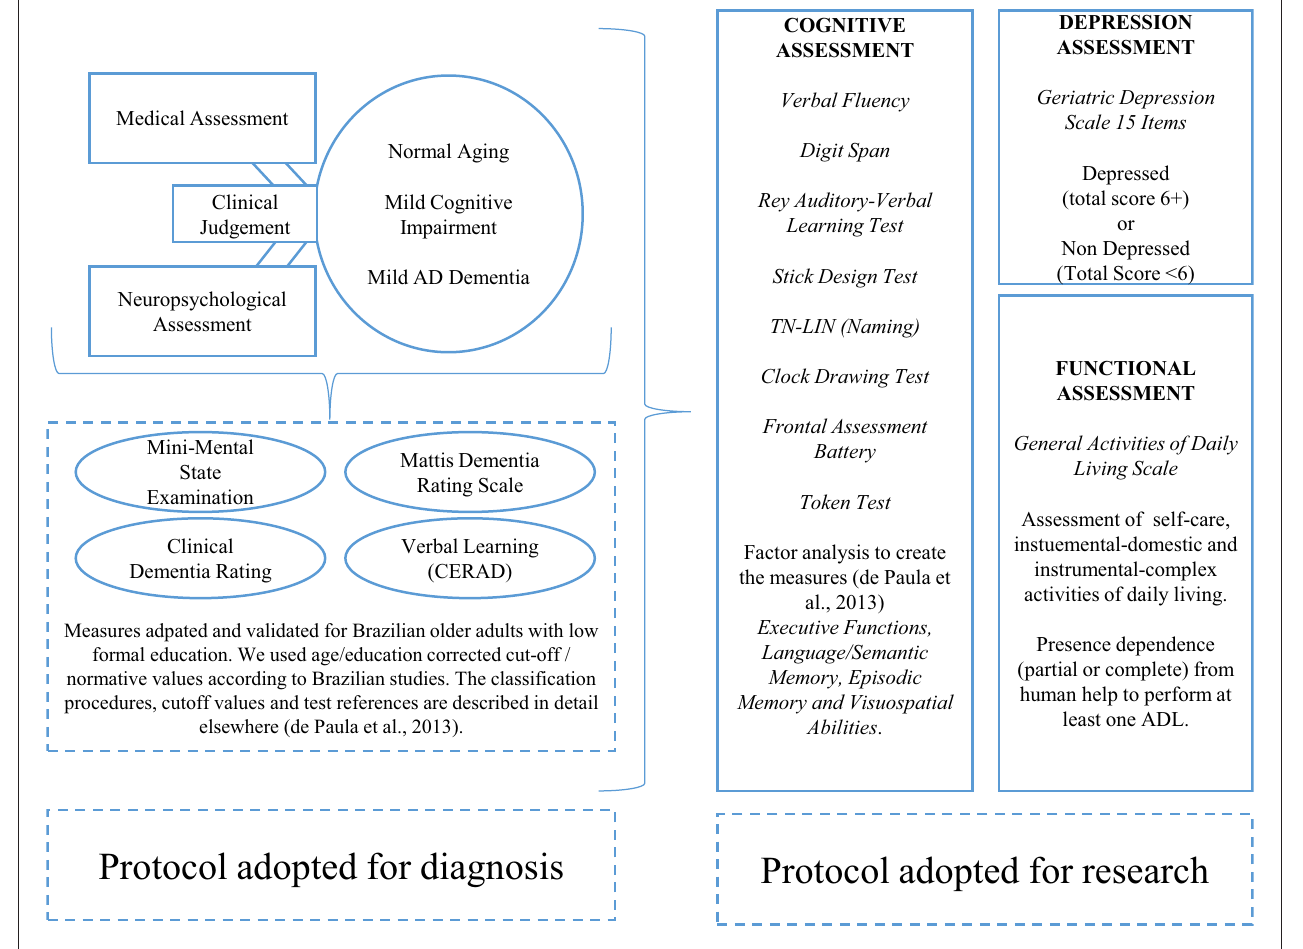
FIGURE 1 | Description of the protocol used for participant’s diagnosis/classification, and procedures adopted for this study. Participants initially underwent a medical and neuropsychological assessment for diagnostic procedures. In all, 274 older adults were divided into Normal Aging (NA, N = 96 ), mild cognitive impairment (MCI, N = 85 ), mild dementia, and Alzheimer’s disease dementia (AD, N = 93 ). After diagnosis, they performed the procedures of the study, involving the assessment of cognitive functioning, depression and activities of daily